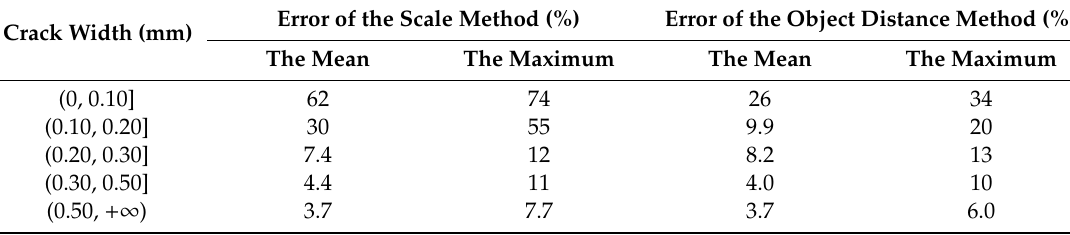
Figure 18. Error comparison curve between the object distance method and the scale method. Table 2. The error comparison between the scale method and the object distance method.